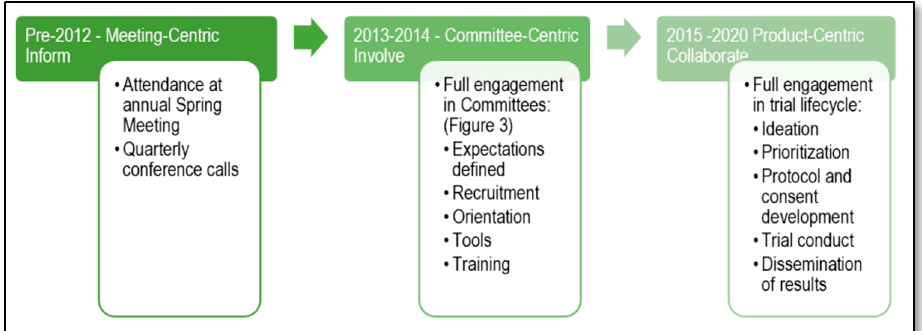
Figure 2. Phases of Patient Representative Engagement Implementation in the Canadian Cancer Trials Group.